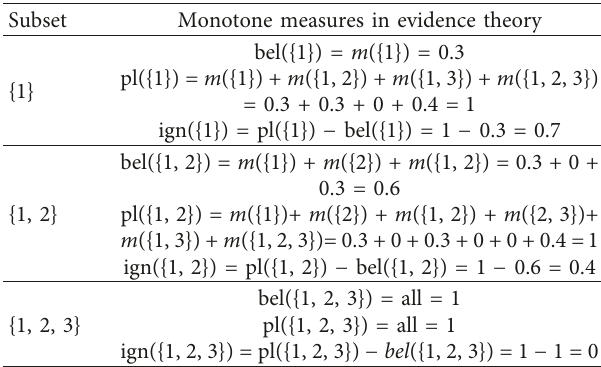
Figure 14: Comparison of the proposed fragility curves for Collapse about the different interval selections with alternative formulation of the proposed fragility curves by using step function and connecting the necessity measure at the center of PGA interval. Table 9: The calculated monotone measures in evidence theory. Table 11: The calculated monotone measures in a special case of evidence theory which is the same with possibility theory. Subset